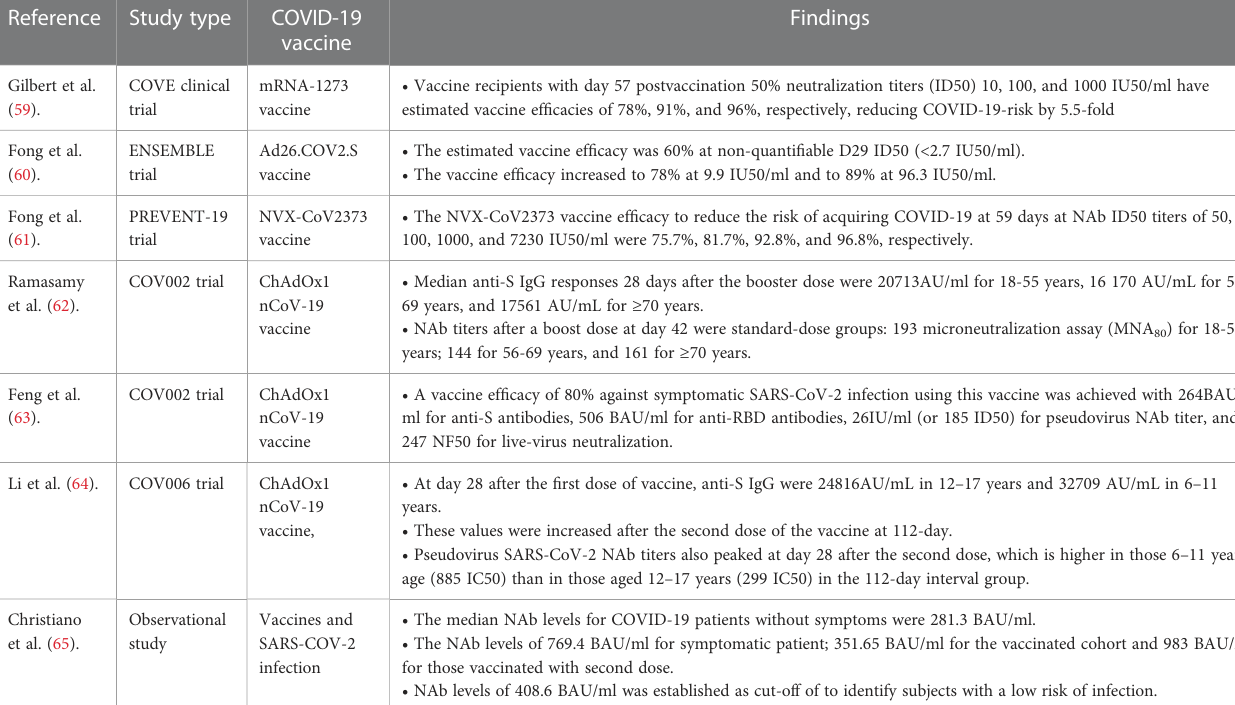
TABLE 1 A summary table on the protective antibody titer and vaccine ef fi cacy against SARS-CoV-2 infections.